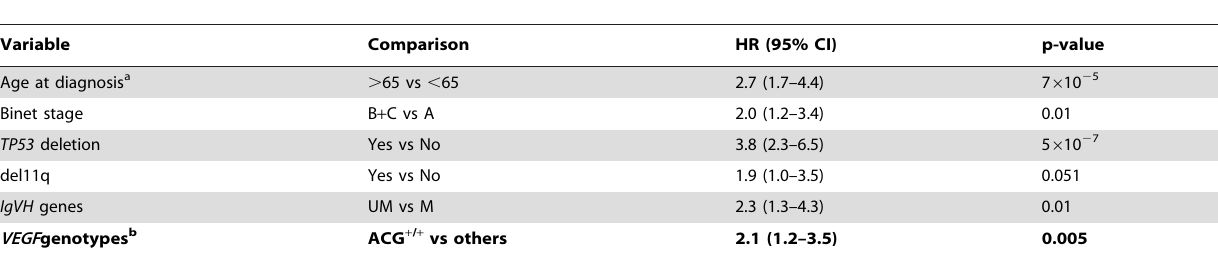
Table 3. Multivariate analysis of the associations between VEGFA rs699947/rs833061/rs2010963 genotypes and OS of CLL patients.